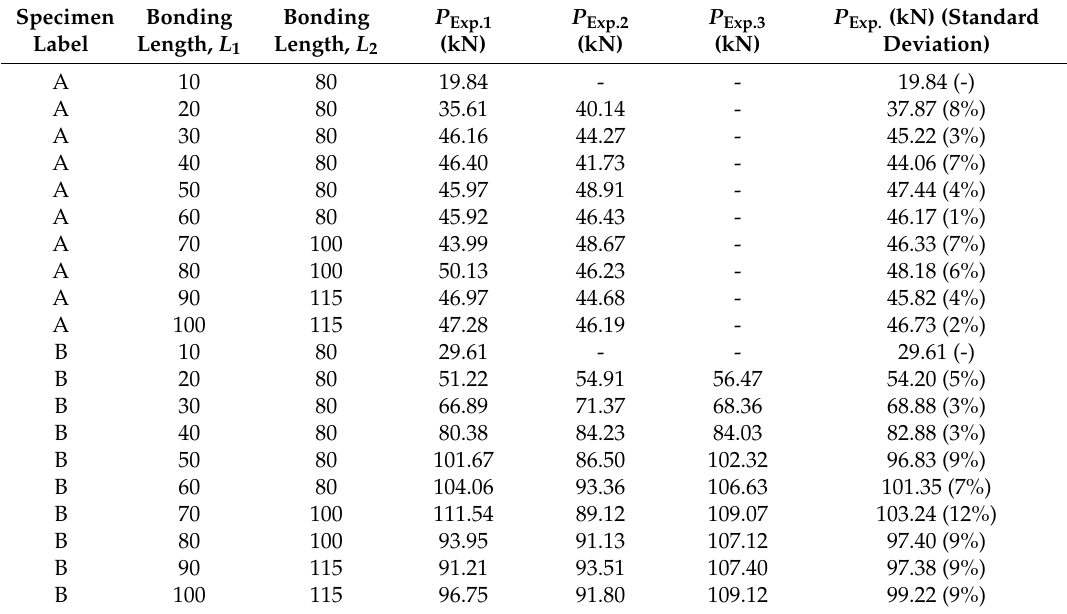
Table 5. Summary of the test results reported by Al-Zubaidy et al., for the double strap joints series A and B